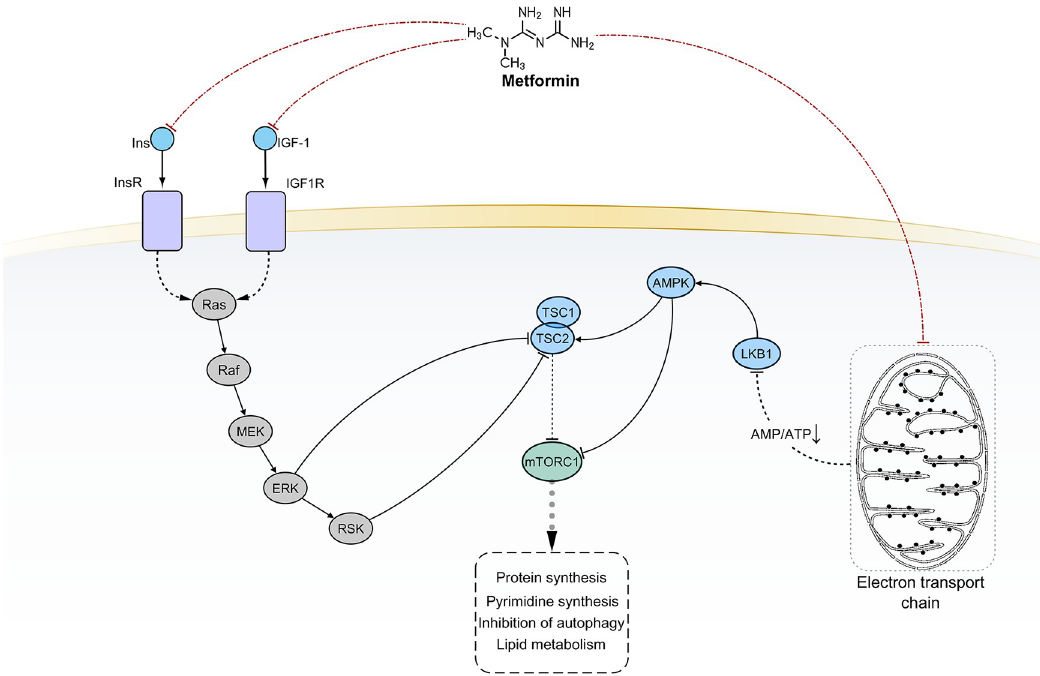
Fig 4. The current model of metformin-mediated pharmacological effects. Black solid edges represent direct interaction between first neighbor nodes. Dashed edges represent indirect interactions between nodes. Red dot-dashed edges evidence scientifically validated interactions considered for PHENSIM